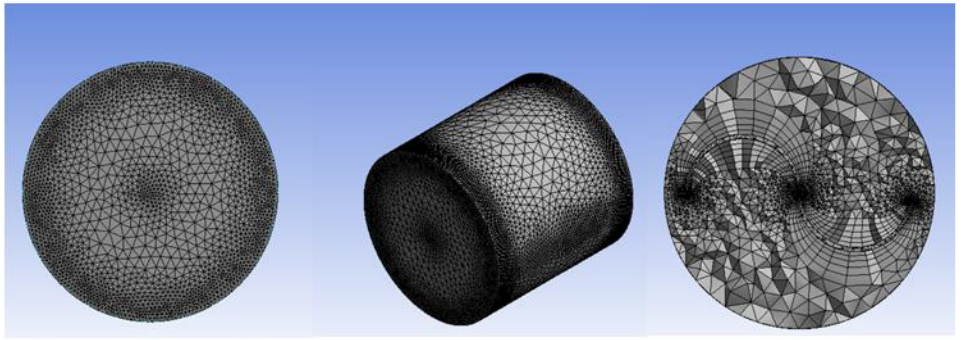
Figure 5: Mesh on a rotary domain.